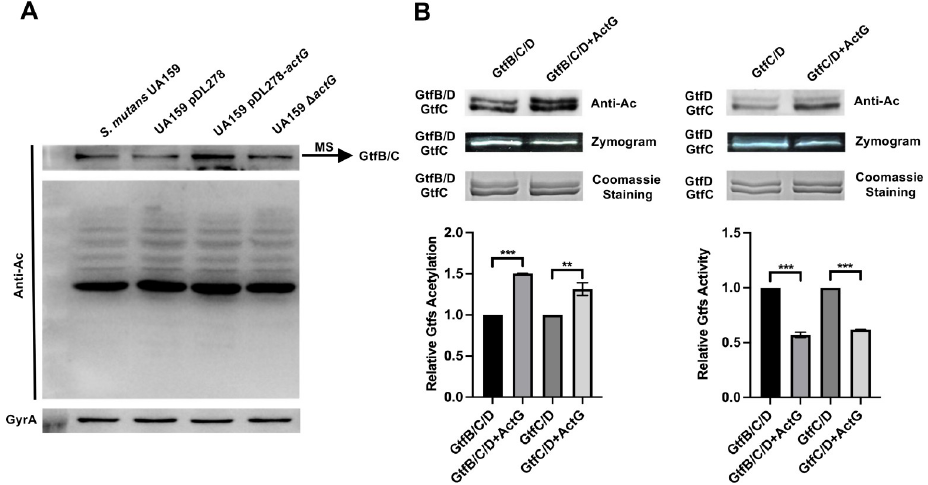
Fig 5. Effect of actG on total proteins acetylation and in vitro enzymatical acetylation. (A) The extracted total proteins were analyzed by anti-acetyl lysine Western blotting. The upregulated acetylated protein was identified by mass spectrometry (MS). (B) Coomassie staining, anti-acetyl lysine Western blotting, and zymogram analysis of Gtfs incubated with ActG as acetyltransferase and Ac-CoA as the acetyl donor for 3h at 37˚C. The band signals were quantified with Image J software and normalized to the control. Results are presented as mean ± SD ( �� P < 0.01 or ��� P <